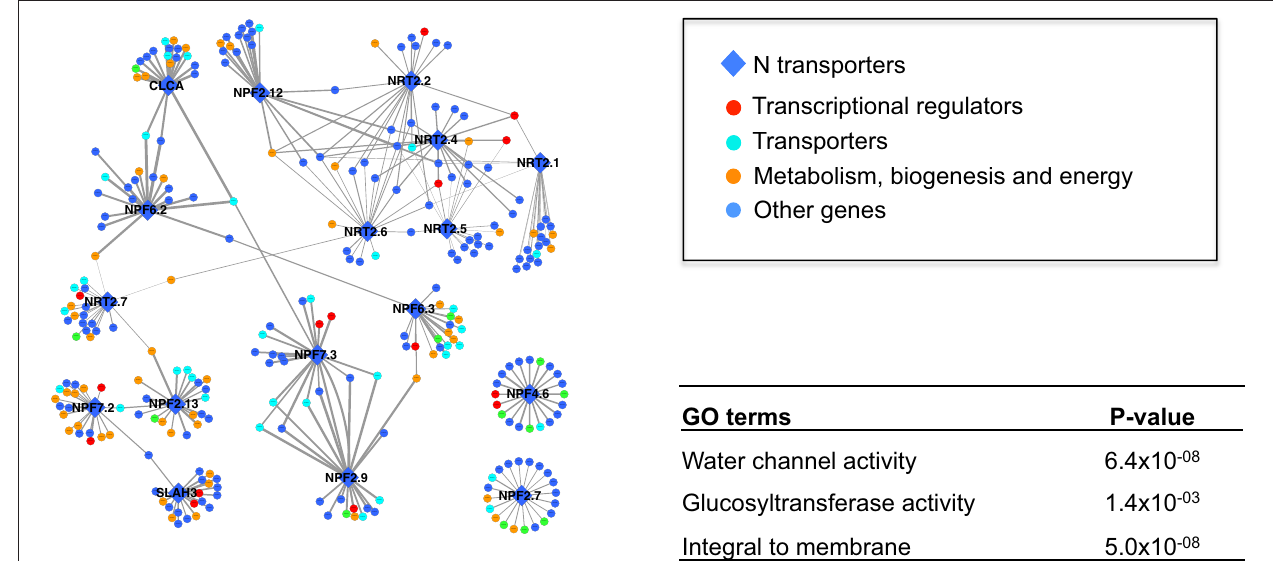
FIGURE 2 | The coexpression network of 17 N transporters. Only the top 20 coexpressed genes for each N transporter were included. The width of the edge is corresponding to the weight of average coexpression among 320 GEO datasets. A high resolution version of this figure and the coexpression weight can be found in Supplemental Materials ( Figure S3 and Table S3 ).